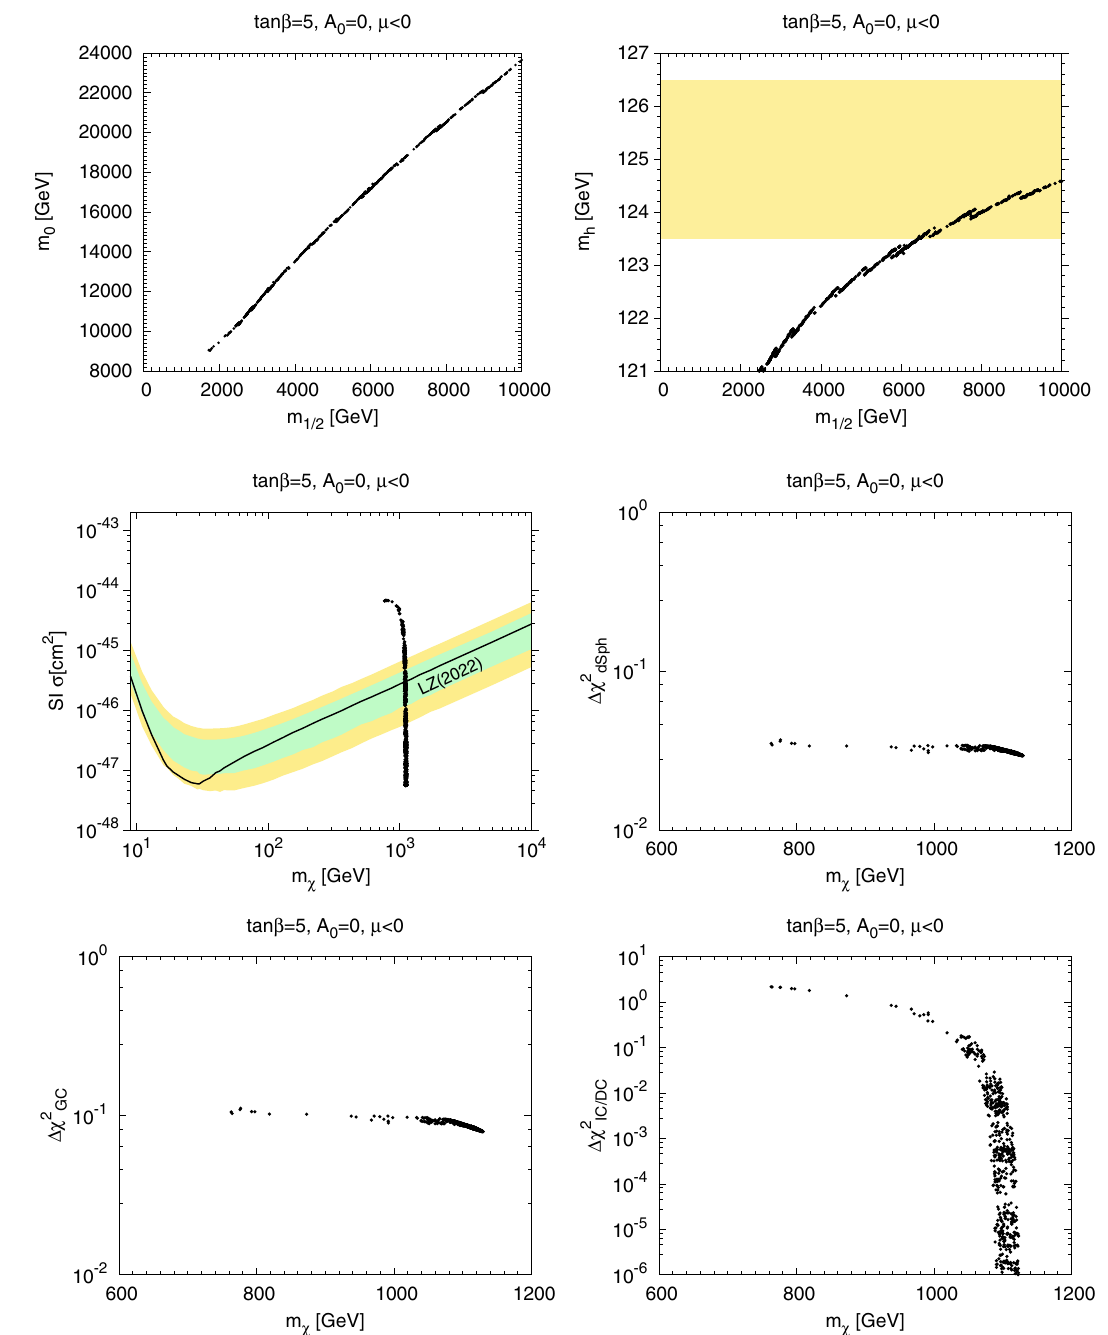
Fig. 18 The ( m 1 / 2 , m 0 ) plane, the m h , spin-independent direct scattering and indirect constraints for the case tan β = 5, A 0 = 0 and μ < 0